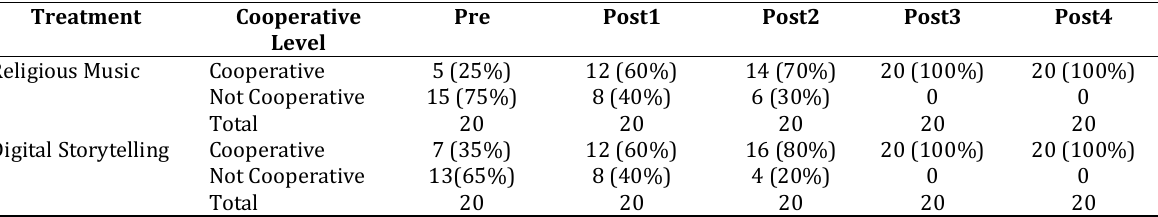
Table 2 Distribution of Respondents Based on Cooperative Level Before and After Religious Music and Digital Storytelling Were Given Treatment Cooperative Religious Music